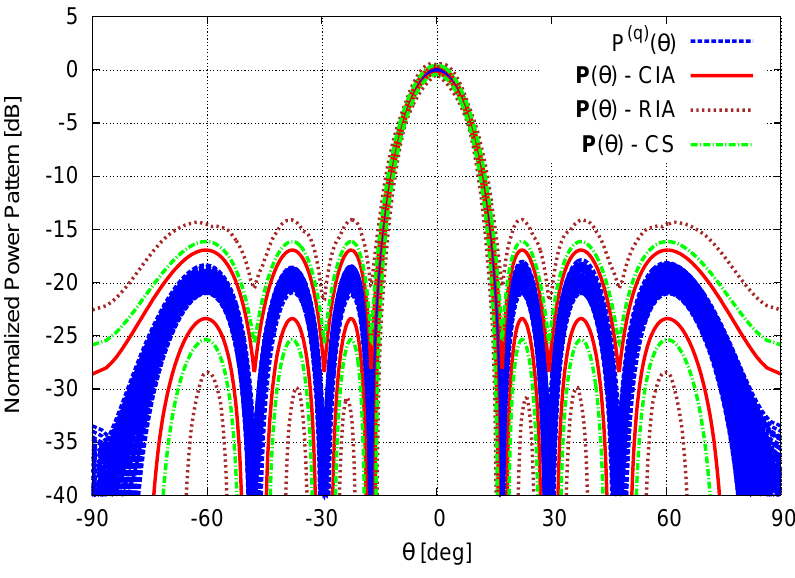
Figure 4. Calibration Error ( N = 8, d = λ ; Dolph–Chebyshev pattern: SLL ref = − 20 dB)—Plot 2 of Q = 10 5 Monte Carlo power patterns, P q ( θ ) , q = 1, ..., Q , along with the interval power pattern bounds as computed by the CIA, the RIA , and the CS